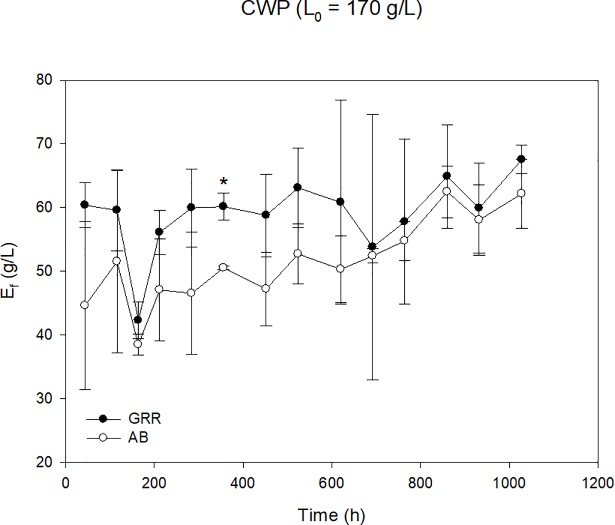
Evolution of ethanol concentration employing K. marxianus DSM 5422 on inorganic supports [glass Raschig rings (GRR) and alumina beads (AB)] during 14 fermentation cycles (Li = 170 g/L).Asterisks indicate the existence of significant differences (p < 0.05) between supports for a given batch.